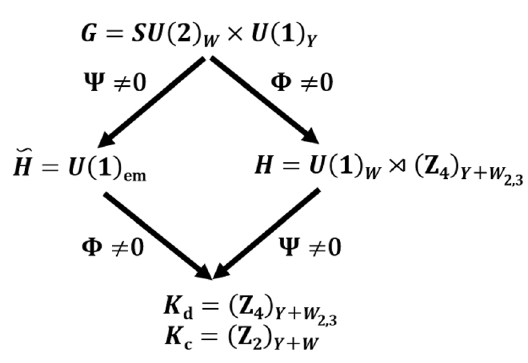
Figure 1 . Spontaneous symmetry breaking patterns.